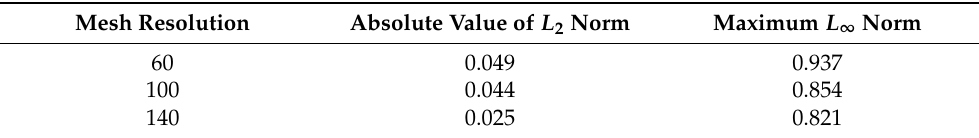
Figure 2. ( left ) Schematic of the pressure inside ( p d ) and pressure outside ( p b ) the bubble used to calculate theoretical pressure according to Young-Laplace law, ( right ) The validation of Young- Laplace law. Straight lines indicate analytical results and scattered points indicate numerical results from SPH method. Table 1. Compariosn between the exact analytical results and SPH results in the pressure computation in the case of 2D droplet simulation with 60, 100, and 140 particles per